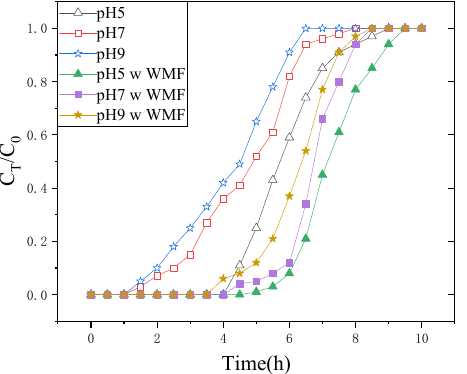
Figure 5. Breakthrough curves of nZNI/AC mediated removal of Sb(III) for different pH. pH = 5, 7, and 9; flow rate = 10 mL·min − 1 ; H = 20 cm; C 0 = 1 mg·L − 1 .